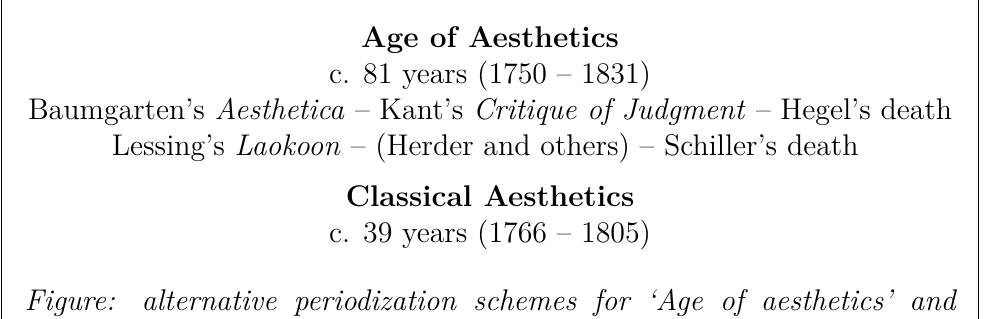
Figure: alternative periodization schemes for ‘Age of aesthetics’ and ‘Classical